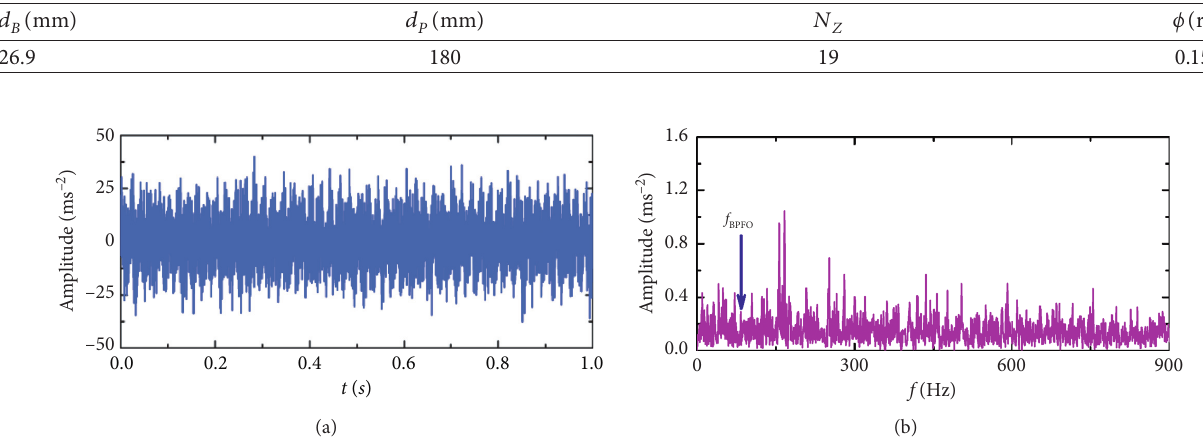
Figure 12: The collected outer-race fault signal and its Hilbert envelope spectrum: (a) time-domain waveform and (b) Hilbert envelope spectrum of signal in